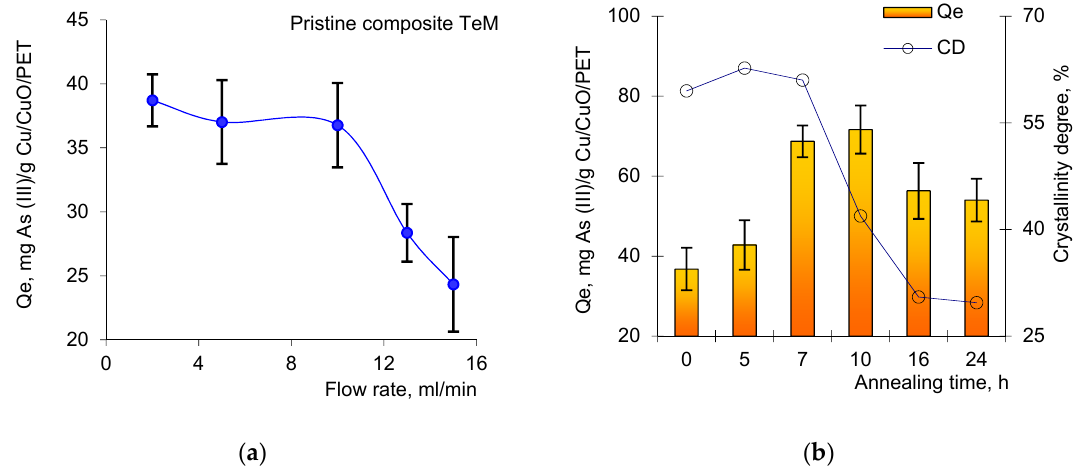
Figure 11. Change in As(III) sorption capacity at equilibrium ( Q e) depending on pumping speed of working solution across the pristine composite TeMs ( a ) and Q e as a function of thermal annealing times at 140 ◦ C and their corresponding degree of crystallinity ( b ).